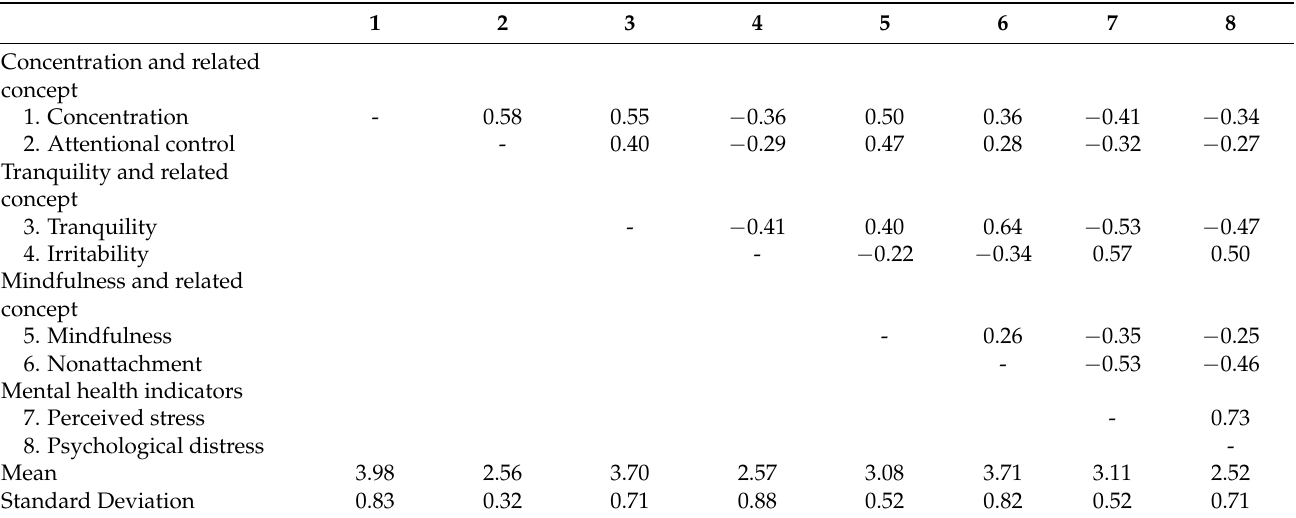
Table 2. Means, standard deviations, and bivariate correlations among all